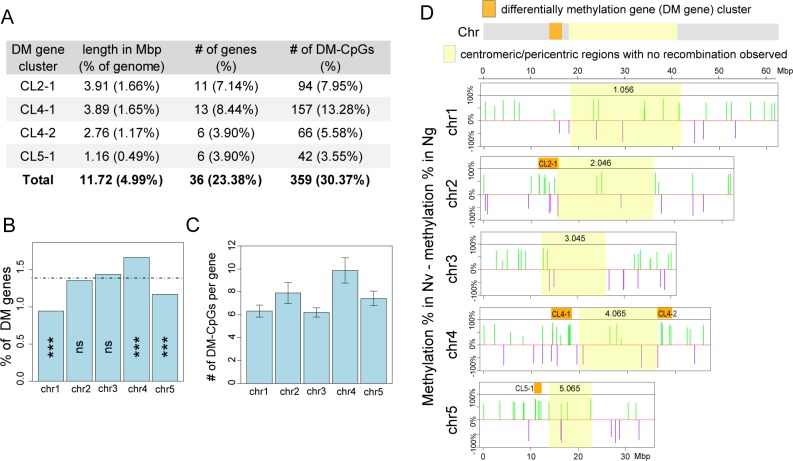
Genes that are differentially methylated (DM genes) between N. vitripennis and N. giraulti are clustered in the genome.(A) Summary of four DM gene clusters (CL2-1, CL4-1, CL4-2, and CL5-1) on Nasonia chr2, chr4, and chr5. The clusters’ physical length (in Mbp), number of DM genes in each cluster, number of differentially methylated CpGs (DM-CpGs), and their percentages in the entire genome are listed. (B) Barplot of percentage of DM genes on five Nasonia chromosomes. Expected percentage of genes for each chromosome under a random, uniform distribution is drawn as a dotted horizontal line. Statistical significance is calculated from permutation tests (ns: p-value > 0.05; *: p-value < 0.05; **: p-value < 0.01; ***: p-value < 0.001). (C) Barplot of average number of differentially methylated CpGs (DM-CpGs) per gene on five Nasonia chromosomes. (D) Plot of physical location and degree of DNA methylation divergence between Nv and Ng for 178 DM genes along five Nasonia chromosomes. The bar heights represent average methylation differences between Nv and Ng, calculated by Nv minus Ng methylation percentage. Nv methylated genes are labeled in green and Ng methylated genes are labeled in purple. The yellow-shaded regions are the centromeric/pericentromeric regions with extremely low recombination (no recombination observed in the population for generating the Nasonia linkage map in [50]). The four DM gene clusters are indicated by orange boxes. Data presented in this figure can be found at http://dx.doi.org/10.5061/dryad.qf2t8.